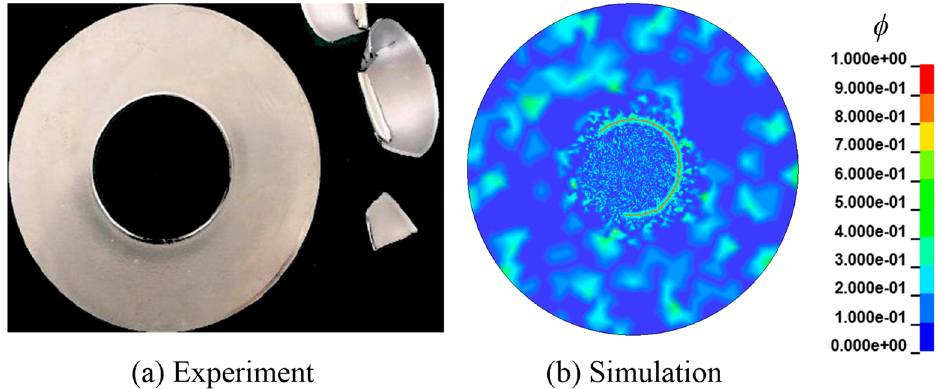
Figure 19. Propagation process of the hydrogen − embrittlement crack.